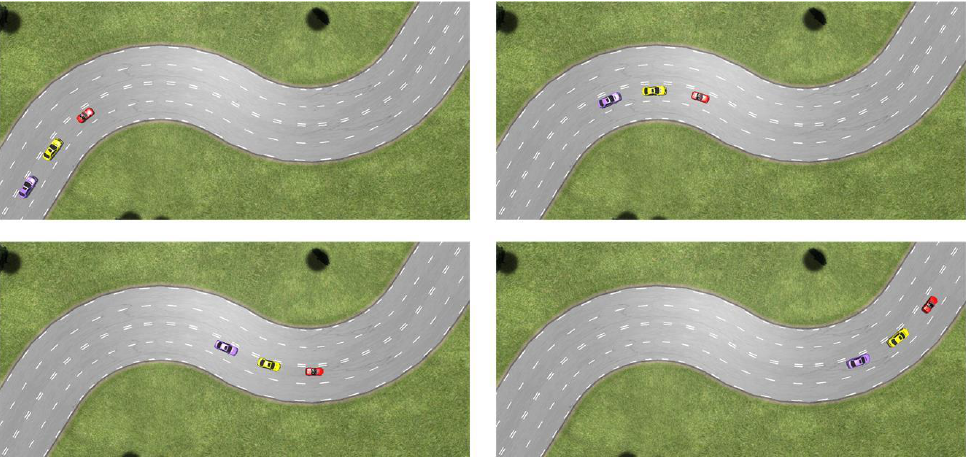
Figure 7. The resulting visualization of 3D simulation for the cooperative car-following system based on eco-driving.